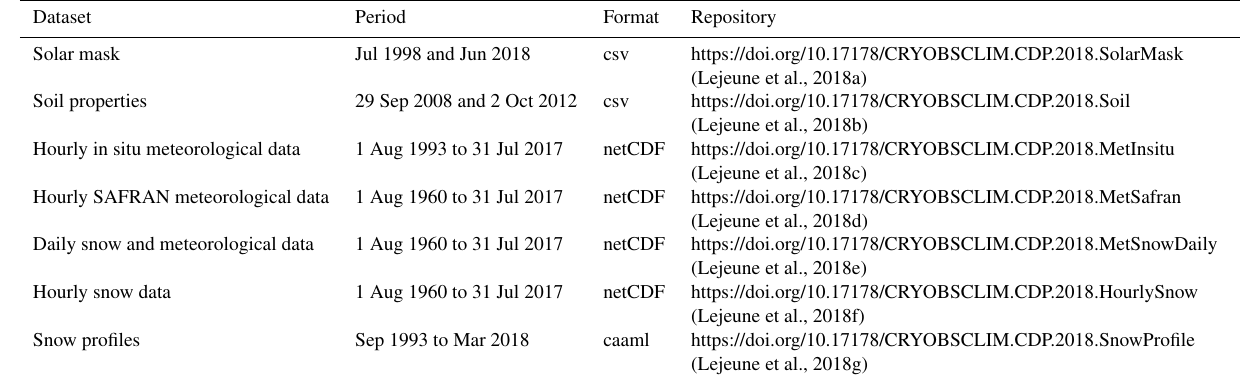
Table 8. Link to the dataset